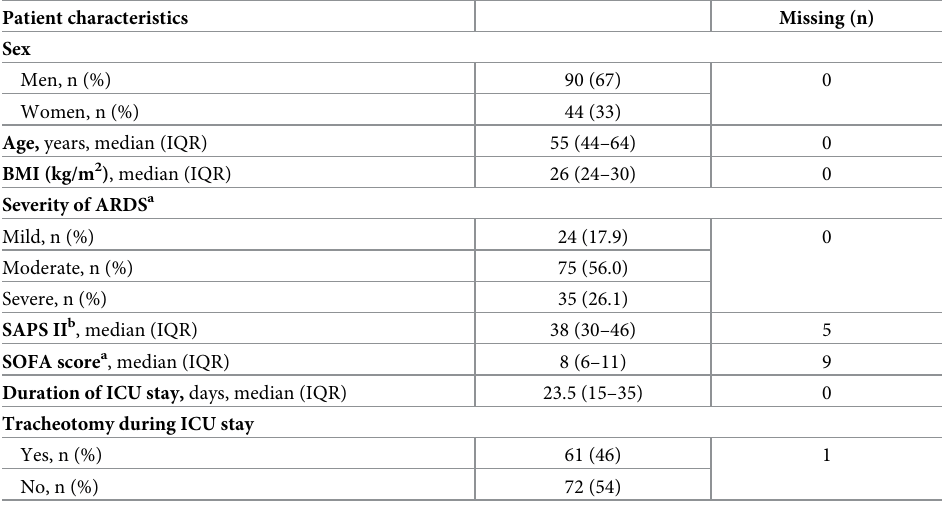
Table 1. Patient characteristics of ARDS survivors with documented analgosedation (n = 134).